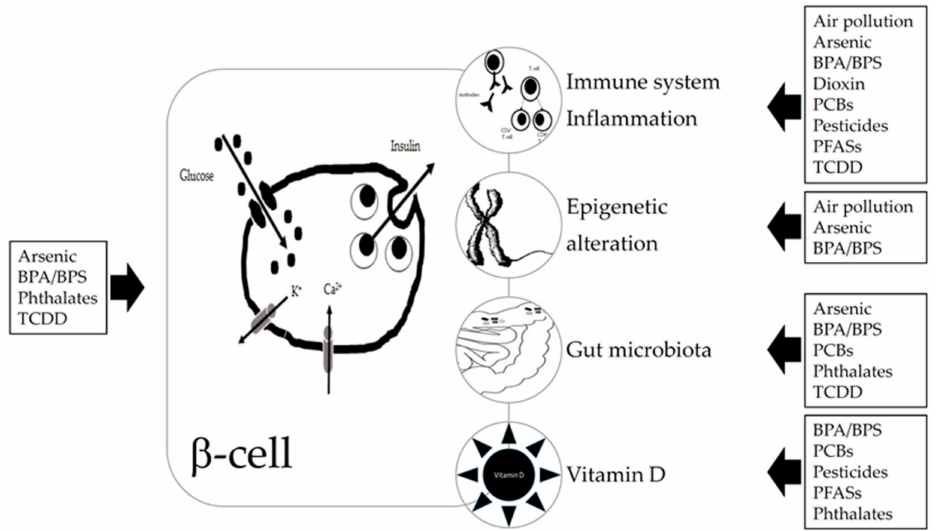
Figure 1. Relationship suggested between endocrine disrupting chemicals (EDCs) and type 1 diabetes (T1D) and suggested mechanisms. EDCs can act directly on beta or immune cells, by binding to receptors (aryl hydrocarbon receptor, peroxisome proliferator-activated receptors, estrogen receptors, and other ones). EDCs can a ff ect the gut microbiota which in turn also interact with the immune system. Some EDCs have been shown to induce epigenetic changes and to impair vitamin